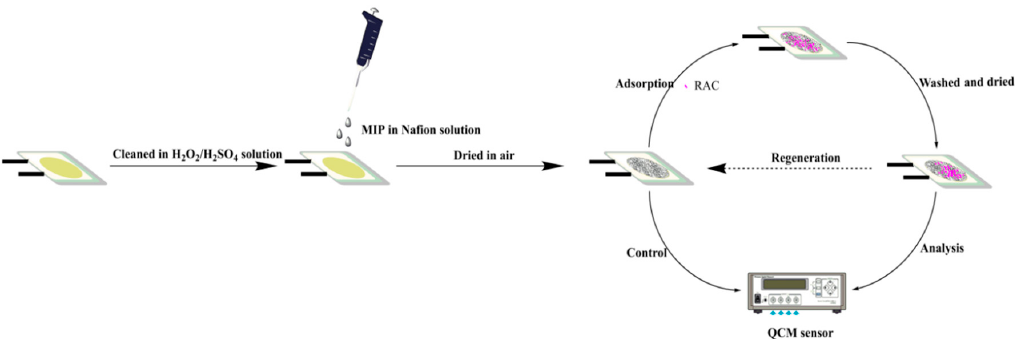
Scheme 1. Schematic diagram of the MIP piezoelectric chip for RAC detection.